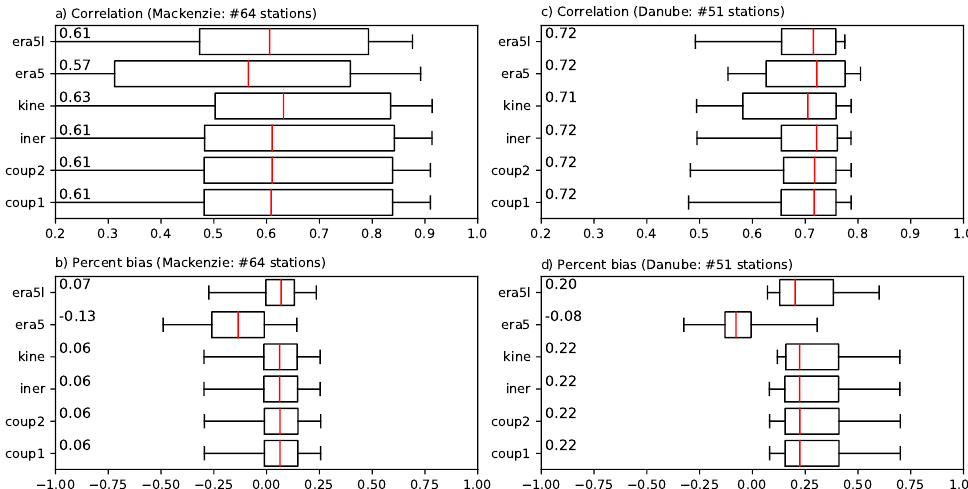
Figure 24. River discharge evaluation distribution of several stations in the Mackenzie ( a , b ) and Danube ( c , d ) basins. The evaluation is performed on daily data, displaying the distribution of correlation ( a , c ) and percent bias ( b , d ) of several model configurations (vertical axis): coup1: 1-way coupling between ECLand and CaMa-Flood; coup2: 2-way coupling between ECLand and CaMa- Flood stand-alone simulations with the flow velocity calculations using the local inertia solution (iner) and kinematic wave (kine), both driven by runoff from coup1. era5 and era5l are also stand-alone CaMa-Flood simulations driven by the runoff of ERA5 and ERA5-Land reanalysis, respectively. The boxplots whiskers extend from percentiles 5 to 95, with the box representing percentiles 25 and 75 and the median in red. The values displayed on the left, close to the vertical axis, identify the median value for each